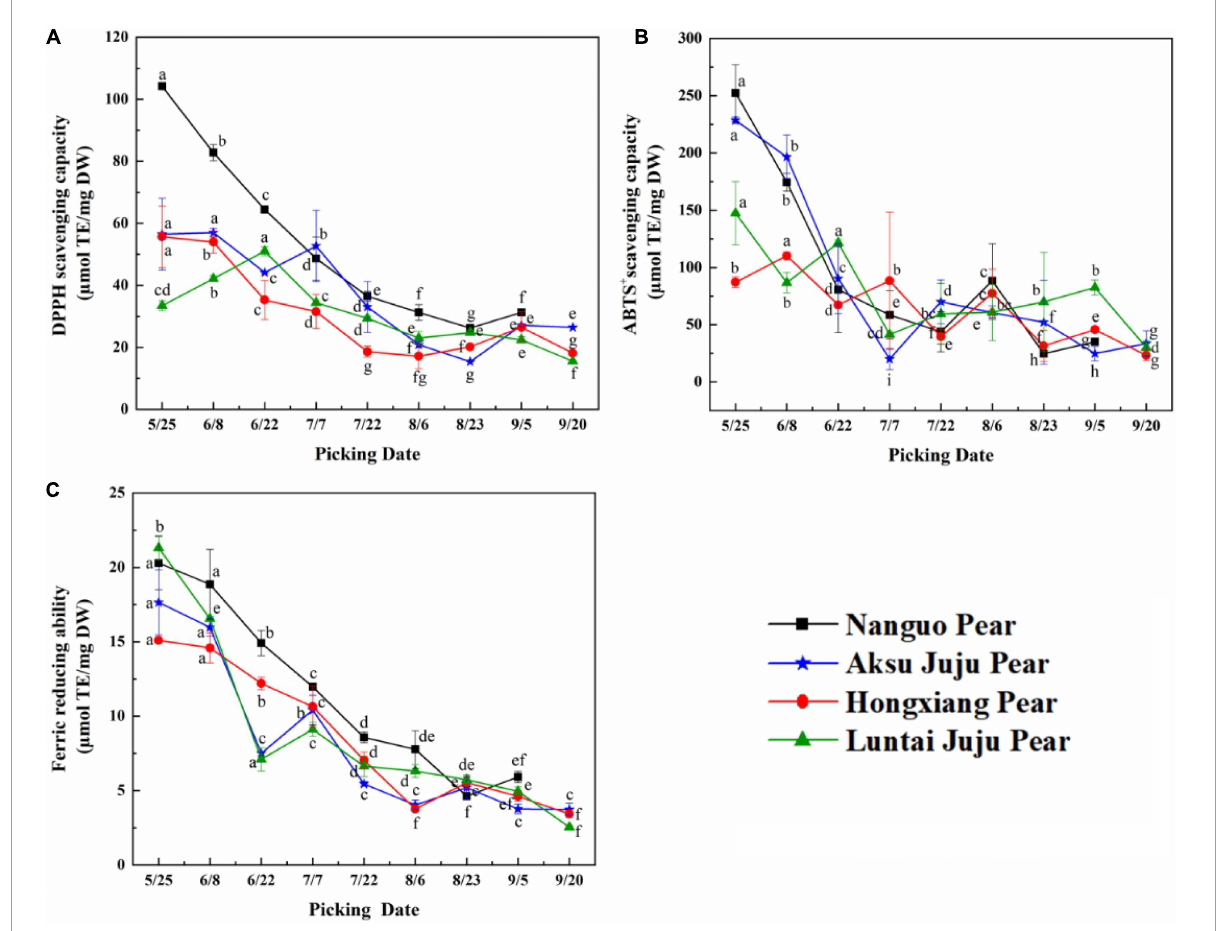
FIGURE6 Changes in the scavenging ability of DPPH, ABTS + free radicals and FRAP of pear fruits. (A) DPPH free radical scavenging ability; (B) ABTS + free radical scavenging ability; (C) ferric reducing ability (mean ± SD, n = 3). Bars with different letters differ significantly ( p < 0.05).